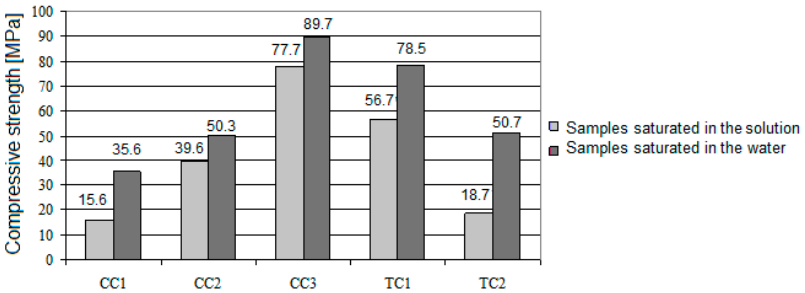
Figure 9. Averaged values of compressive strength of composite samples stored in water and aggressive environments.